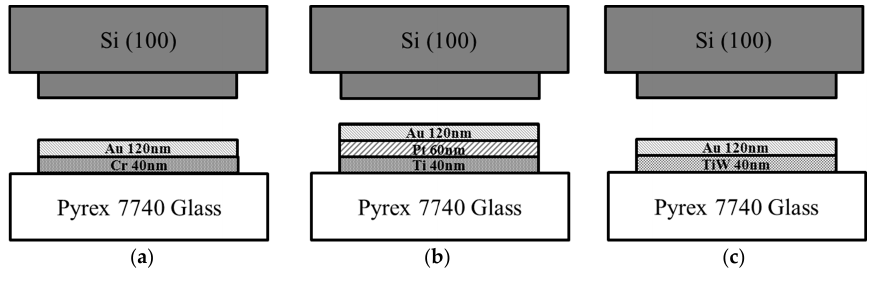
Figure 1 . Schematic diagram of Au/Si eutectic bonding structures: Si structures bonded with patterned ( a ) Cr/Au, ( b ) Ti/Pt/Au, and ( c ) TiW/Au on Pyrex 7740 glass wafer. ( a ) Cr/Au, ( b ) Ti/Pt/Au, and ( c ) TiW/Au on Pyrex 7740 glass